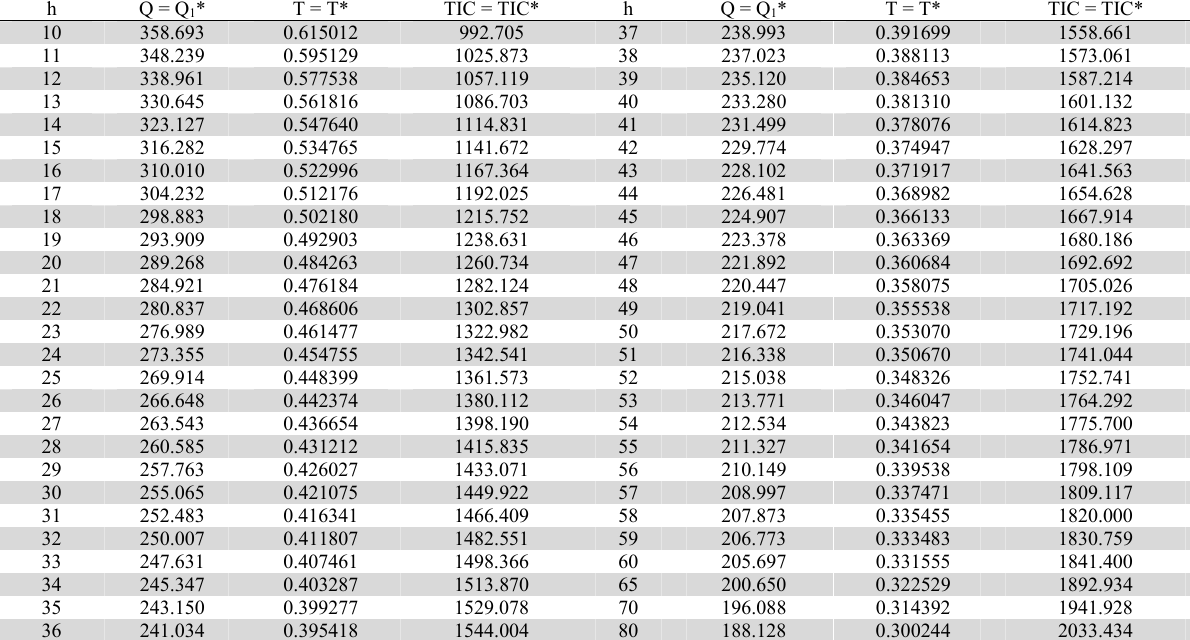
* and TIC = TIC* for different values of ‘h’ 1